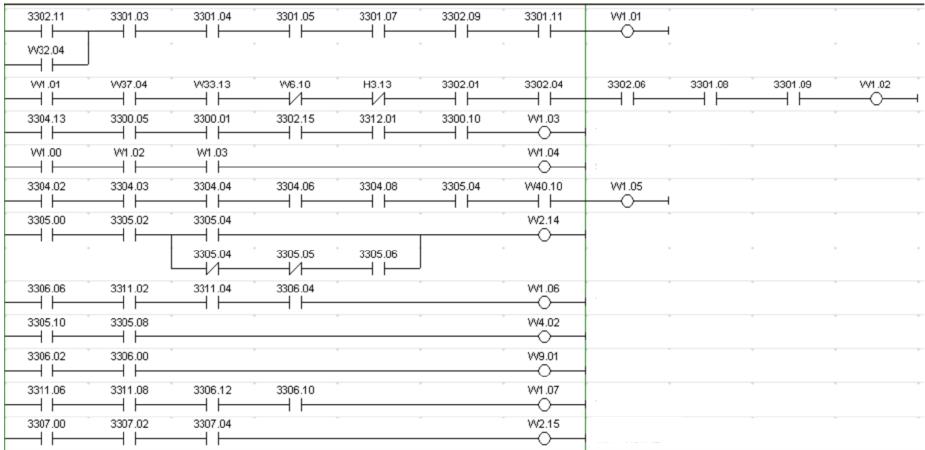
Figure 1. Ladder program from a traditional